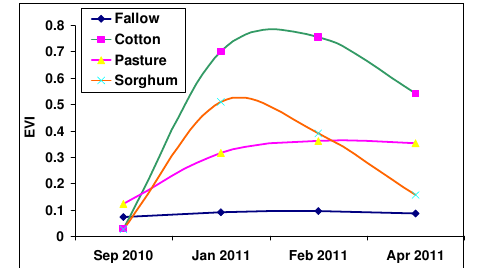
Figure 4. Temporal changes in mean EVI values for different classes during summer 2010 crop season derived from Landsat time series data